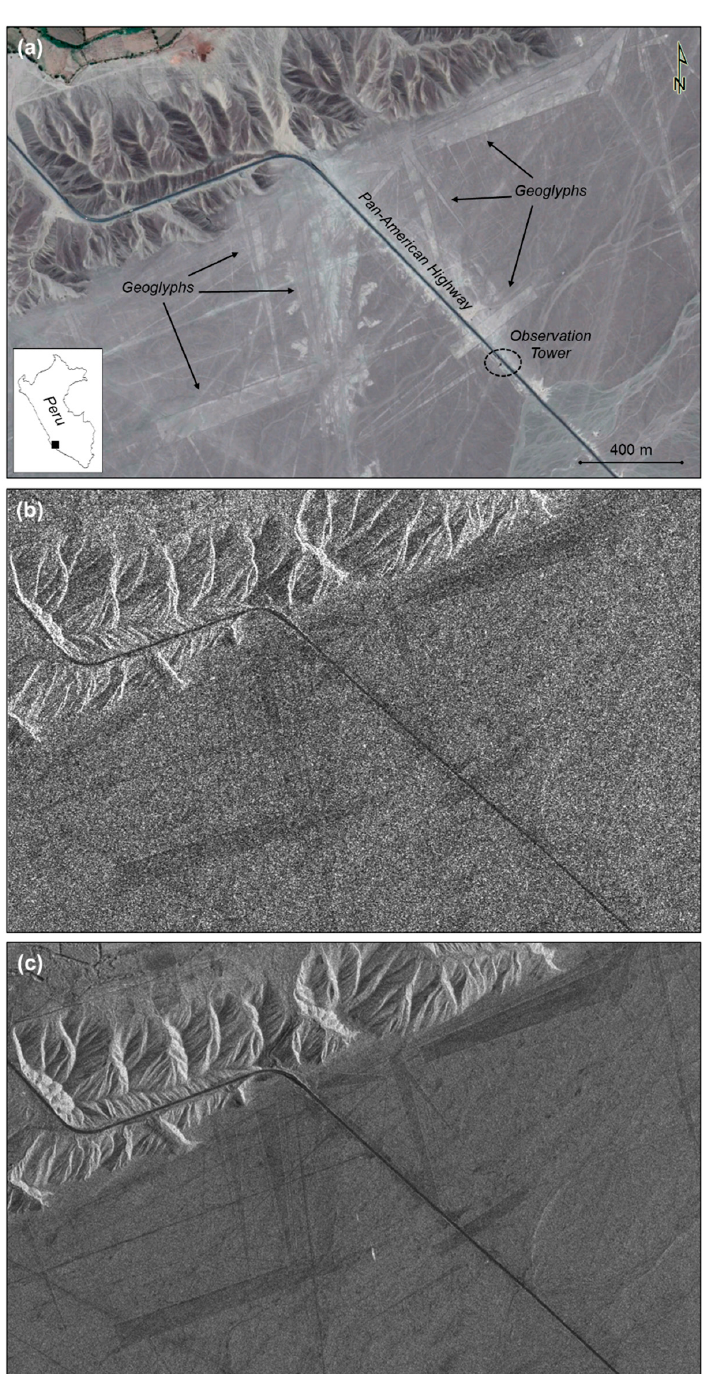
Figure 2. ( a ) A 2016 satellite view of the Nazca Lines (Peru), with indication of some rectangular geoglyphs (Google Earth image © 2018 DigitalGlobe); and comparison of SAR backscattering from COSMO-SkyMed ascending mode scenes acquired on ( b ) 05/07/2018 in StripMap Himage mode (~3 m ground resolution) with horizontal transmit—horizontal receive (HH) polarization and 27° incidence angle, and ( c ) 16/07/2018 in Enhanced Spotlight mode (~1 m ground resolution) with vertical transmit—vertical receive (VV) polarization and 39° incidence angle. COSMO-SkyMed® Products ©ASI—Italian Space Agency—2018. All Rights Reserved.